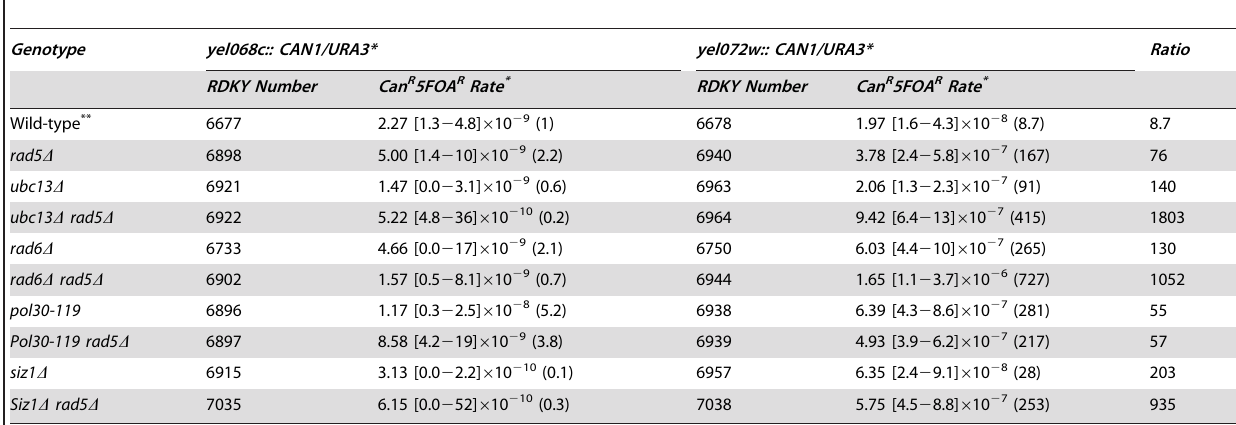
Table 4. Effects of combining rad5 D with mutations in RAD6 -pathway genes on duplication-mediated GCRs.